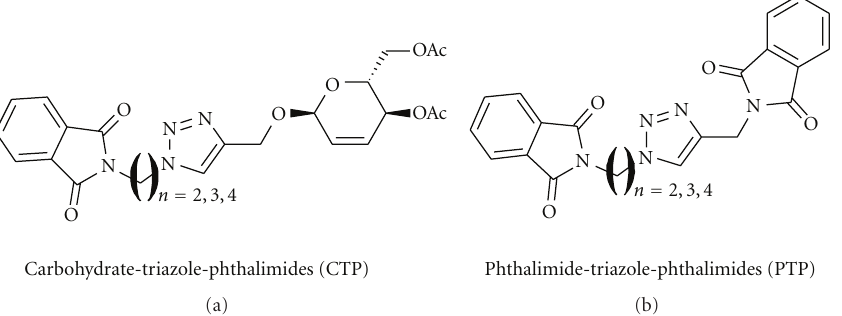
Figure 1: Molecules based on Carbohydrate-Triazole-Phthalimides (CTP) and Phthalimide-Triazole-Phthalimides